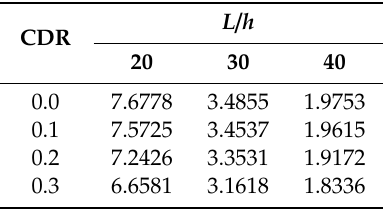
Table 6. Critical buckling loads of C-C cracked FG-X-GPLRC beams ( L 1 / L = 0.5, a GPL / b GPL = 4, b GPL / t GPL = 10 3 , W GPL =